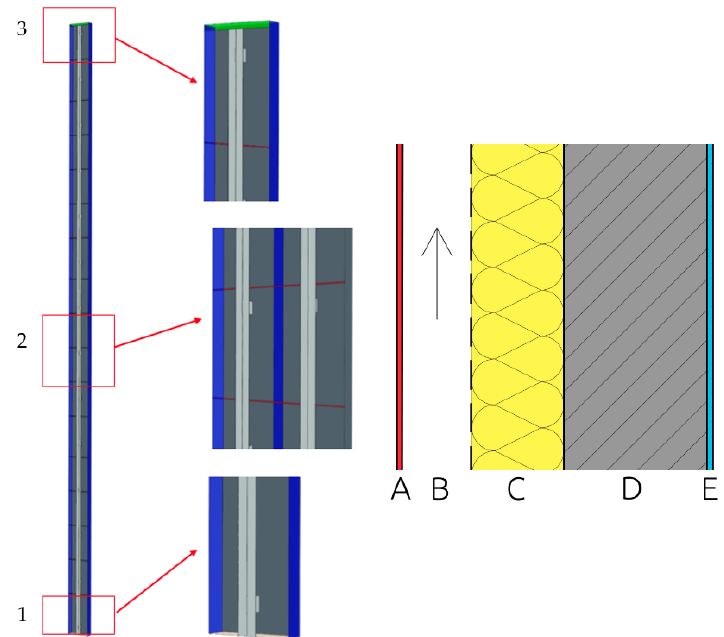
Figure 2. Air gap geometry for CFD simulation and composition of the wall. 1 = air inlet at the bottom, 2 = gaps between cladding, 3 = air outlet at the attic, blue = symmetric condition. Right middle picture shows model with symmetry on. The picture also shows the load-bearing elements—the vertical profiles that line the outer lining of the ventilated gap.